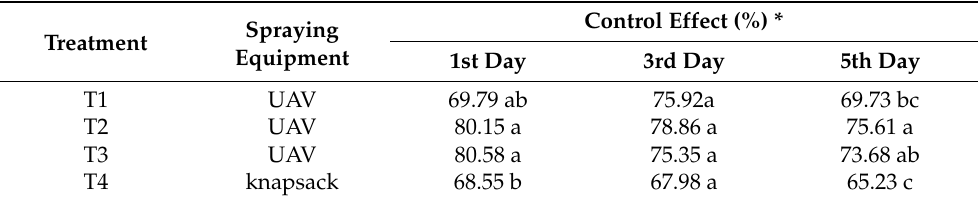
Table 2. The field control effect (%) against cowpea thrips sprayed by UAV and knapsack electric sprayers.